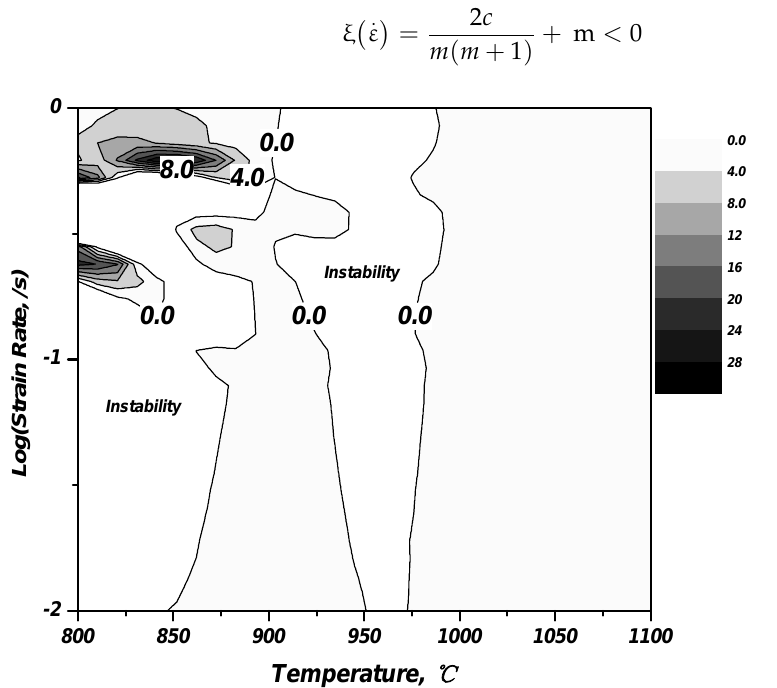
Figure 8. Deformation contour map shown by temperature-log(strain rate) relation of Ti-6Al-4V alloy ( ε = 0.6) by Ziegler’s instability criterion ( ξ ).